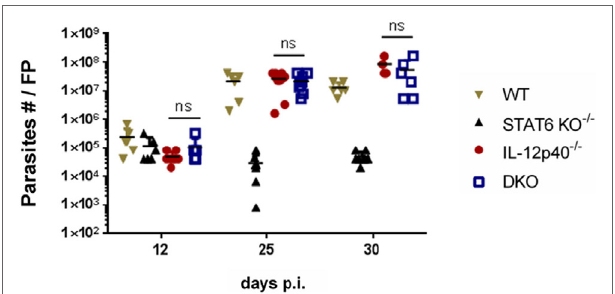
FigUre 3 | Impact of IL-12p40 and STAT6 on parasite control and footpad pathology are independently regulated. Parasitemia levels in the footpads of Leishmania major -infected wild type (WT), IL-12p40 − / − , STAT6 − / − , and double knockout (DKO) BALB/c mice at d12, d25, and d30 post-infection were obtained by the limiting dilution technique. Data represent three independent experiments with at least four footpads per group. Error bars are shown as SD. ns, not significant, * p < 0.05, ** p < 0.01, *** p <